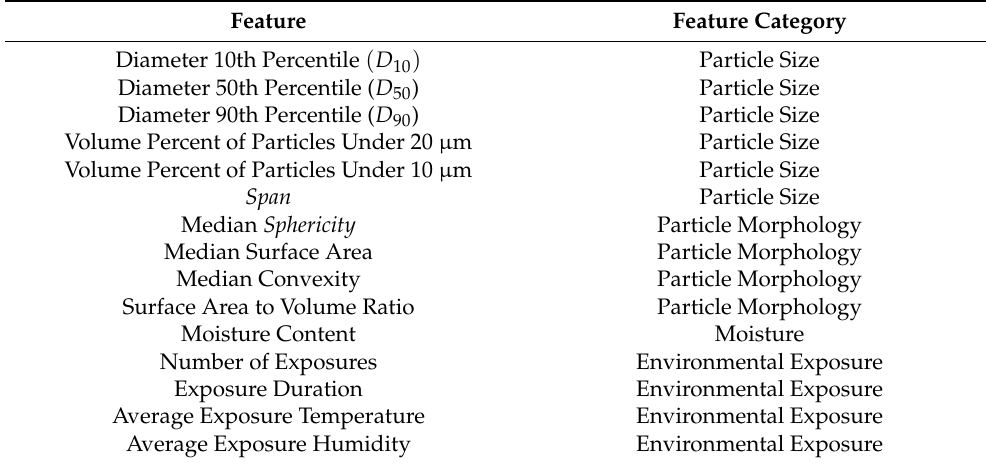
Table 1. Select features included in statistical analysis based upon domain